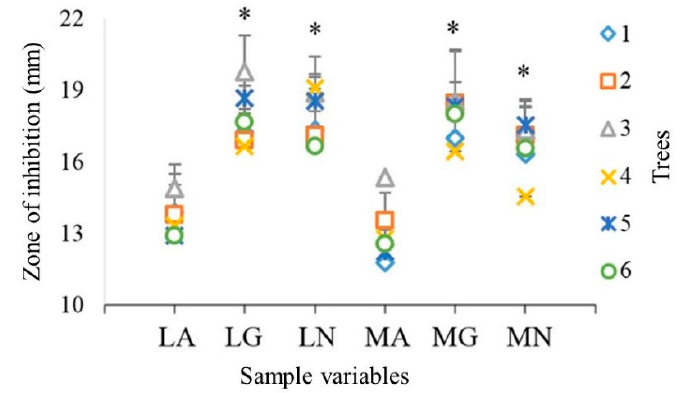
Figure 2. Effect sterilization on the antimicrobial activity of different trees against Staphylococcus aureus . Y axis is the mean ± standard deviation ( n = 3) of zone of inhibition (mm) including the diameter of wooden discs (9.95 ± 0.1 mm); LA = Laser cut autoclaved samples; LG = Laser cut gamma irradiated samples; LN = Laser cut non-sterilized samples; MA = Manual cut autoclaved samples; MG = Manual cut gamma irradiated samples; MN = Manual cut non-sterilized samples; 1–6 number of trees; * p < 0.05.